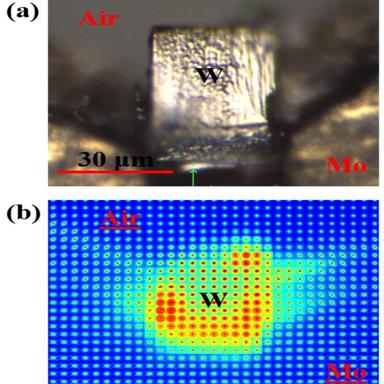
(a) Optical micrograph of a W irradiated specimen mounted on an omniprobe holder and (b) corresponding 2D SAXS map.